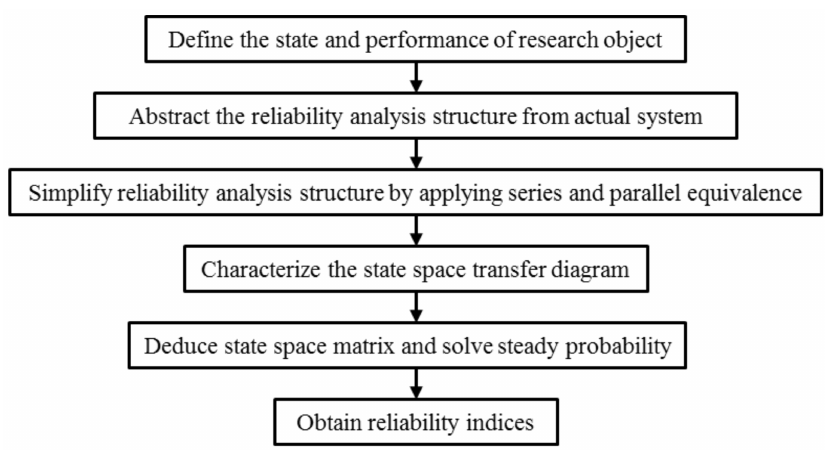
Figure 1. F&D method for reliability analysis of UHVDC transmission